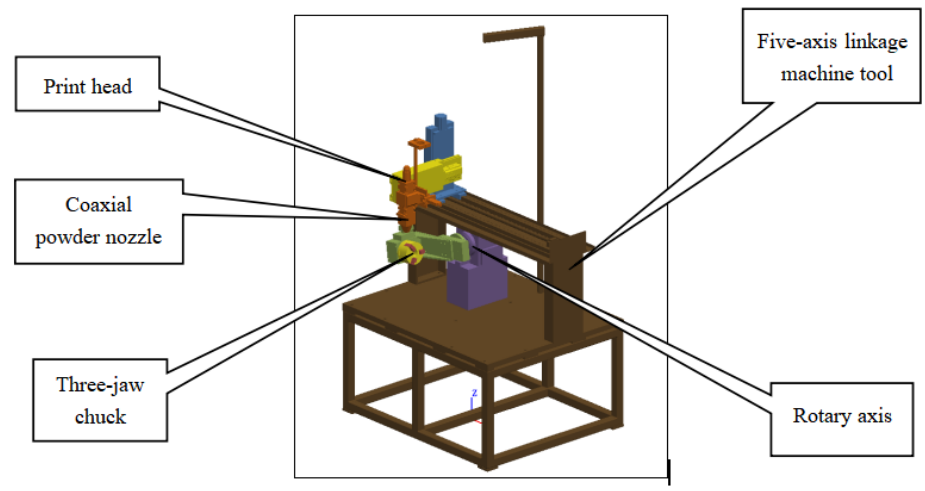
Figure 3. Virtual assembly of LMD equipment model.